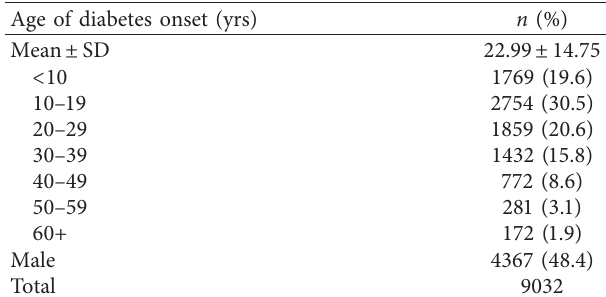
Figure 3: Age of cataracts onset in the type 1 diabetes (T1D) group vs. the Longitudinal Health Insurance Database (LHID) group. Table 3: The demographic features of type 1 diabetes (T1D) pa- tients newly registered during